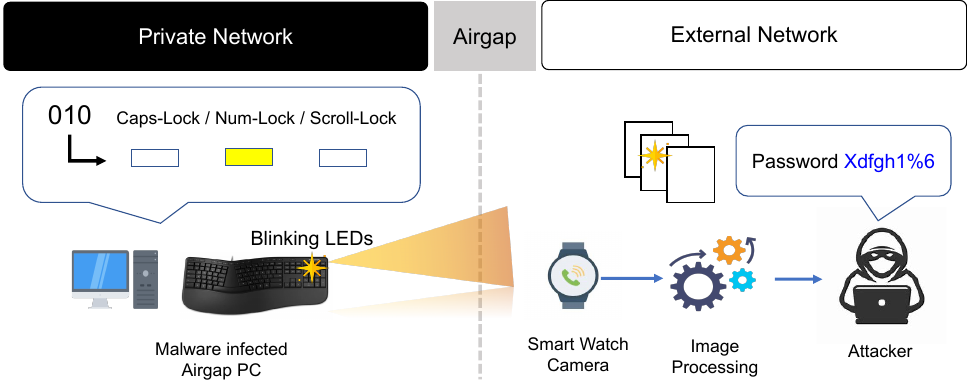
Figure 7. Conceptual diagram of air-gap attack using keyboard LED